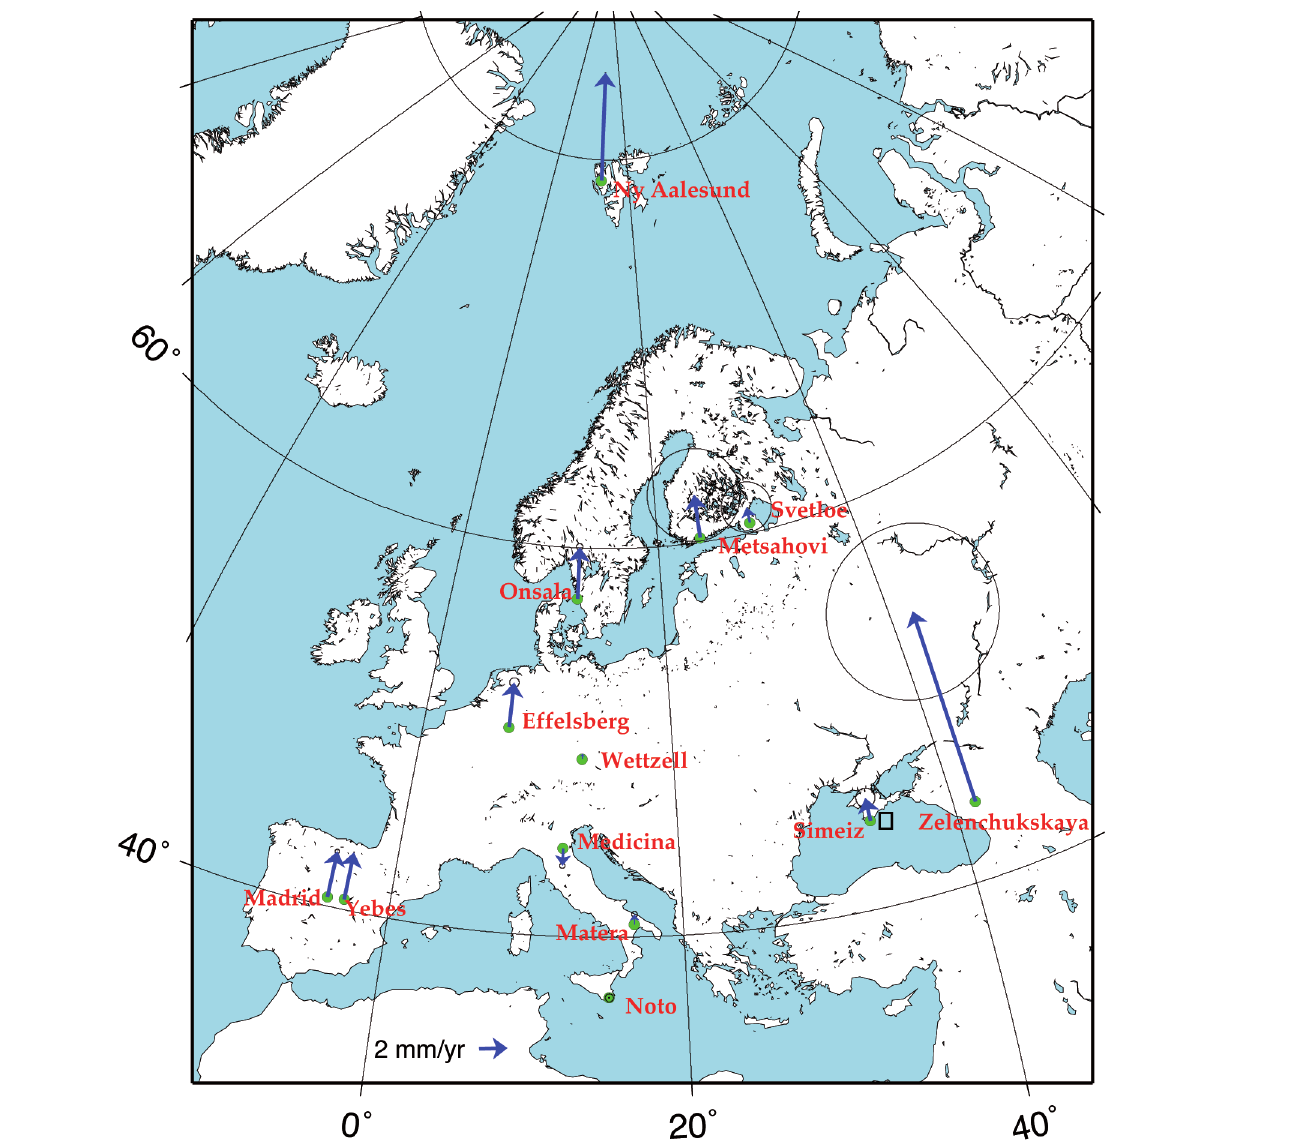
Figure 4. Local vertical velocities of the European VLBI sites (Table 1, column